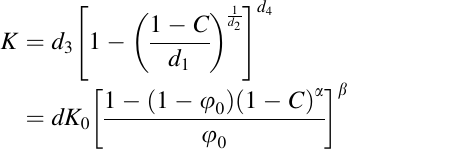
Fig. 13 Evolution law of permeability and compression parameters: a specimen 2–1, b specimen 2–4, c specimen